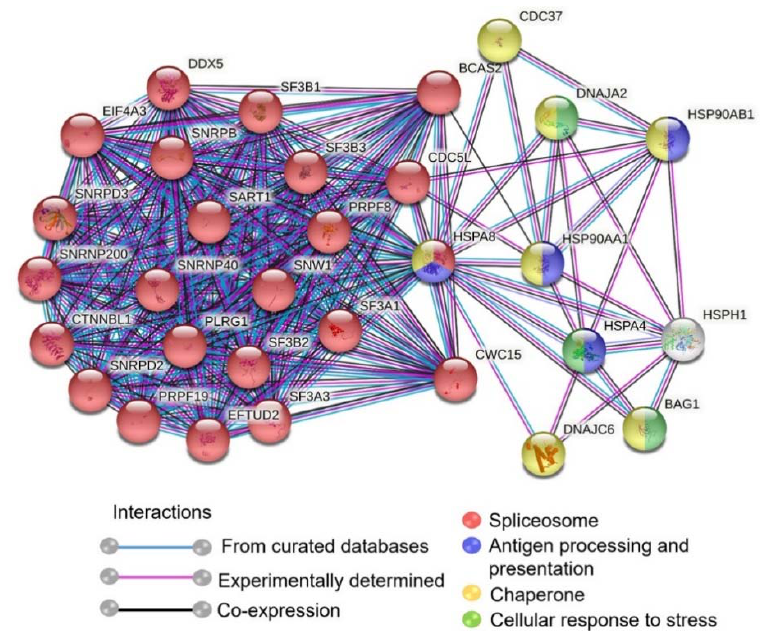
Figure 7. Protein–protein interaction network (PPI) of HSPA8 using STRING database. The edges represented in the full network indicate both functional and physical protein associations. Network